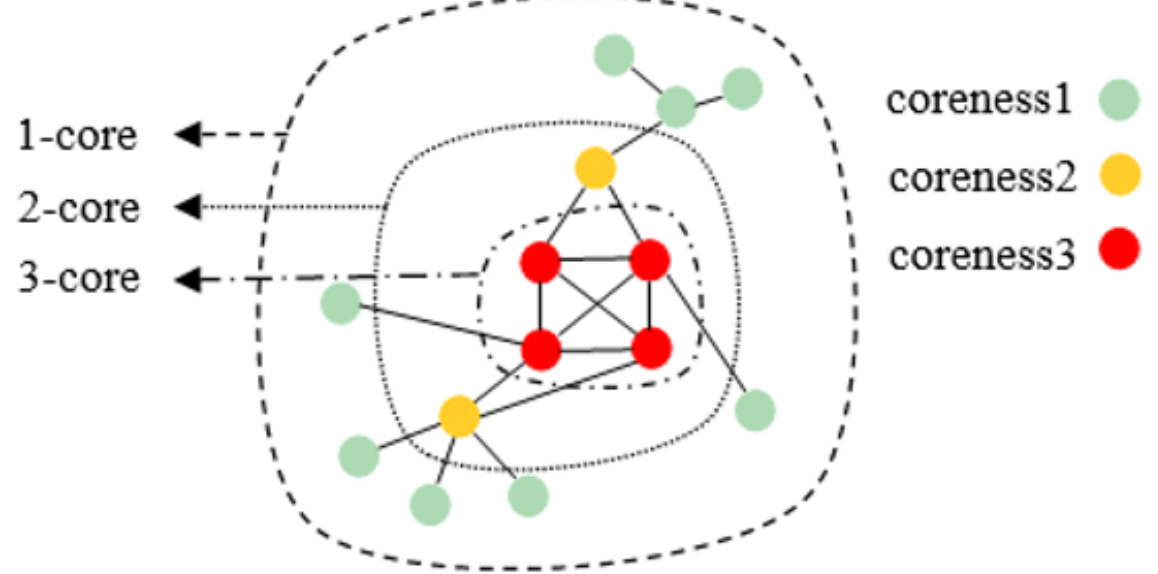
Figure 1. Illustration of the k-core decomposition of a small network. The sets of nodes belonging to the 1-core, 2-core, and 3-core are enclosed by different types of lines. The different k-shells can also be distinguished by the colors of the